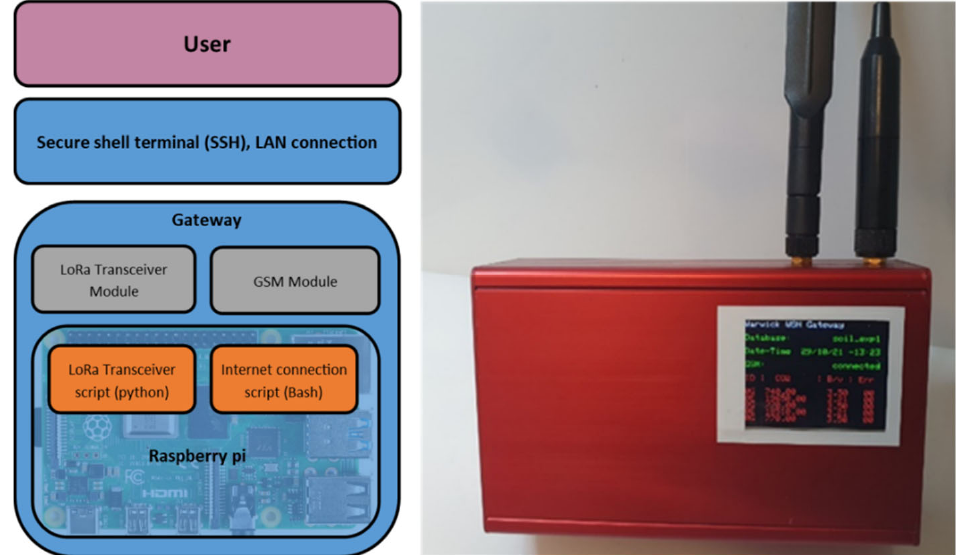
Figure 5. Gateway block diagram and physical setup.